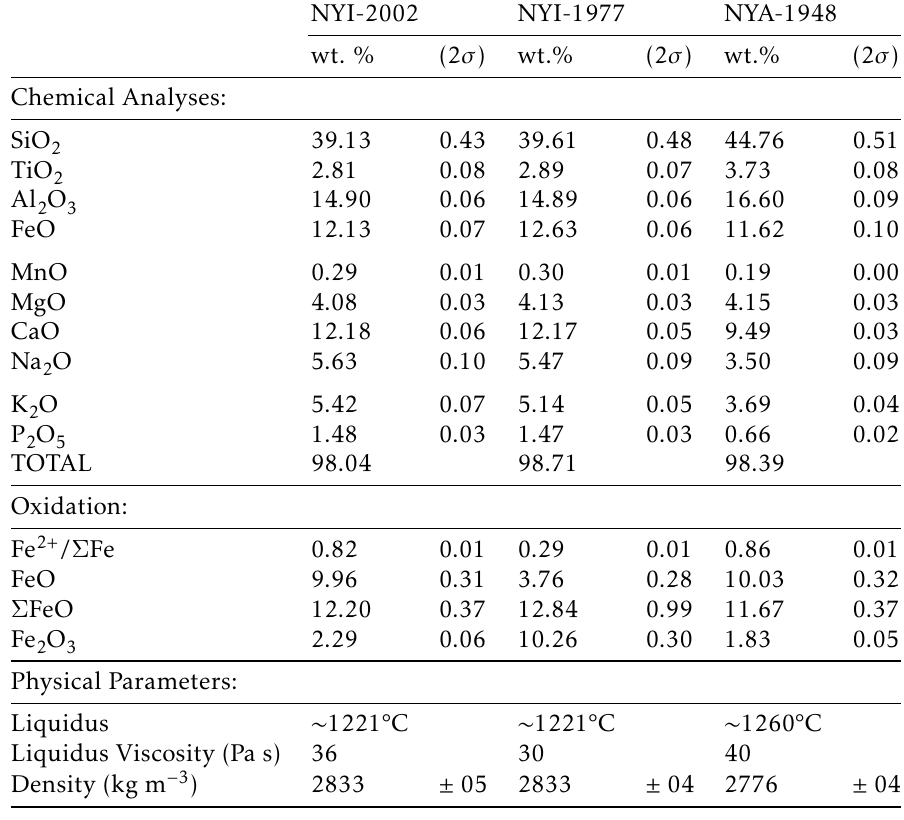
Table 1 – Composition (in wt.%), iron oxidation, and physical parameters for bulk, crystal-free, remelted glass. NYI-2002 is the sample from the 2002 lava flow, NYI-1977 is from the 1977 lava flow, and NYA-1948 is from a lava flow in 1948. 2 σ is based on 6–8 analyses of the bulk, remelted